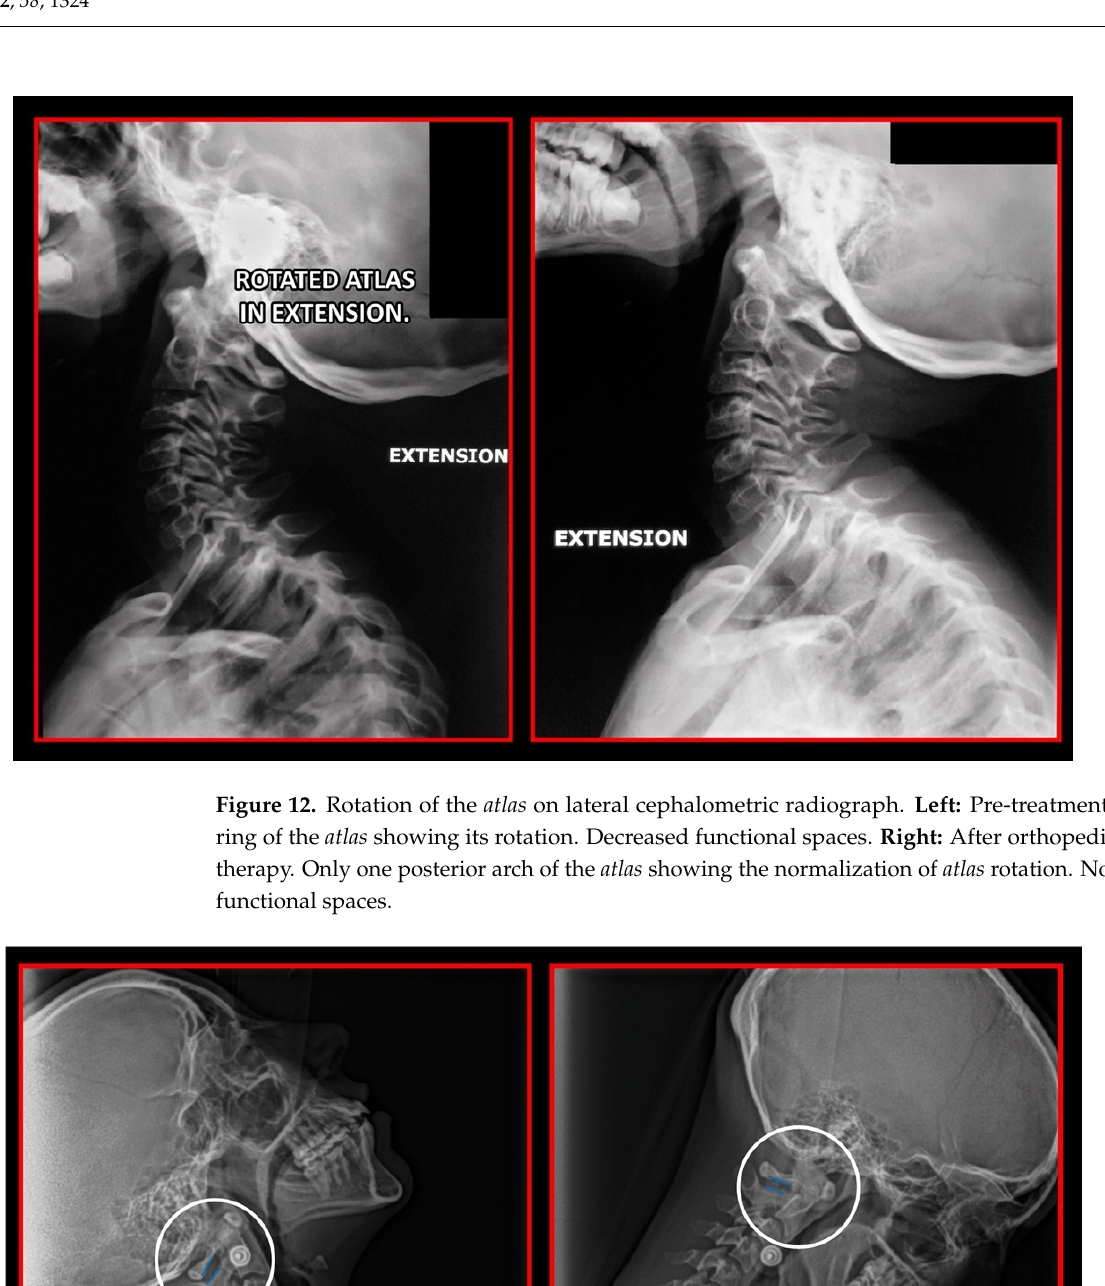
Figure 11. Rotation of the atlas on lateral cephalometric radiograph. Left: Pre-treatment. Double ring of the atlas showing its rotation. Decreased functional spaces. Right: After orthopedic manual ther- apy. Only one posterior arch of atlas showing normalization of atlas rotation. Normalized functional spaces.